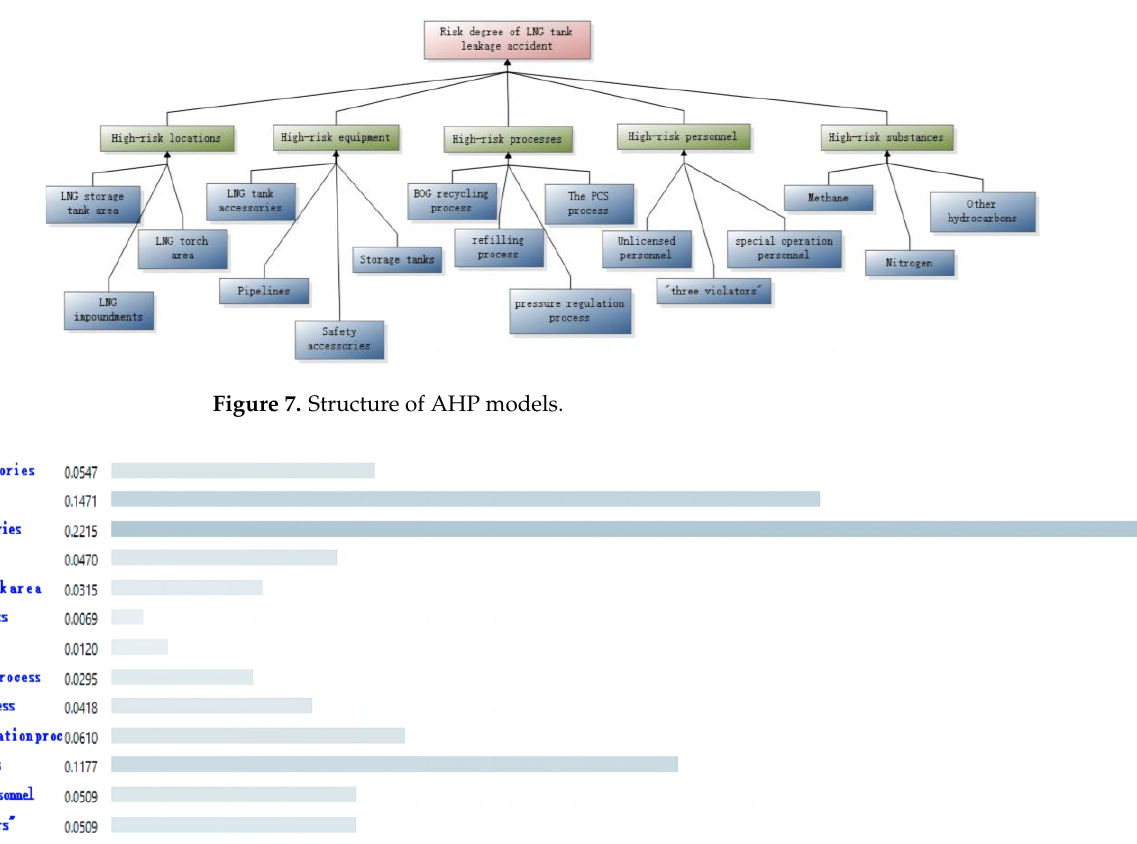
Figure 6. Priority of secondary indicators.